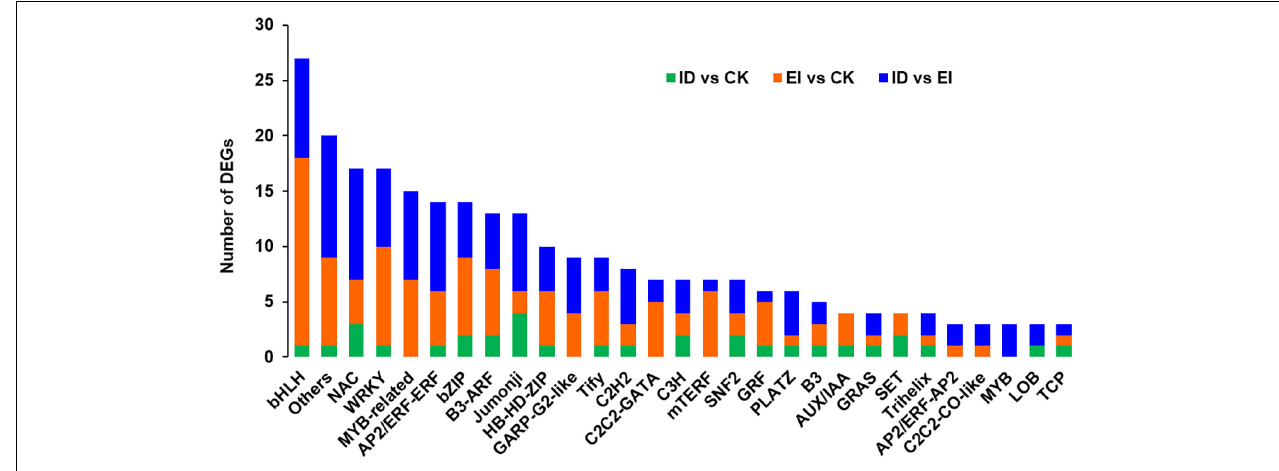
FIGURE 6 | Analysis of transcription factors (TFs) and transcriptional regulators (TRs) in ID, CK and EI.